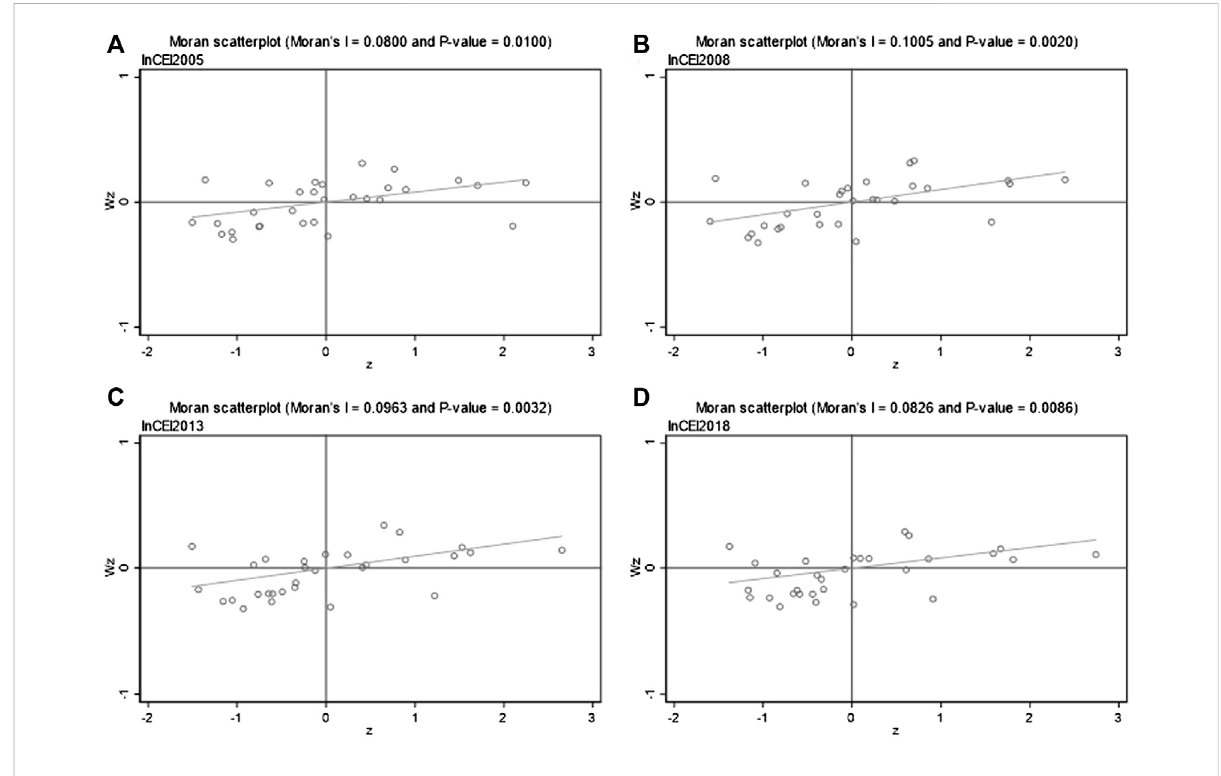
FIGURE 4 Moran I scatter plot of CO 2 emission intensity in individual